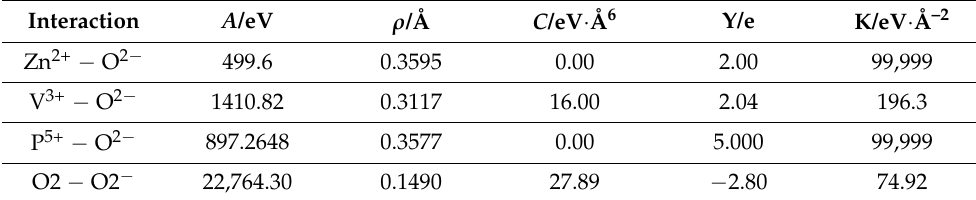
Table 1. Buckingham potential parameters used in the classical simulations of Zn 3 V 4 (PO 4 ) 6 [47,48]. Two-body ( Φ ij ( r ij ) = A ij exp ( − r ij / ρ ij ) − C ij /r ij 6 ), where A, (cid:36) , and C are parameters reproducing the experimental data. The values of Y and K are shell charges and spring constants, respectively.